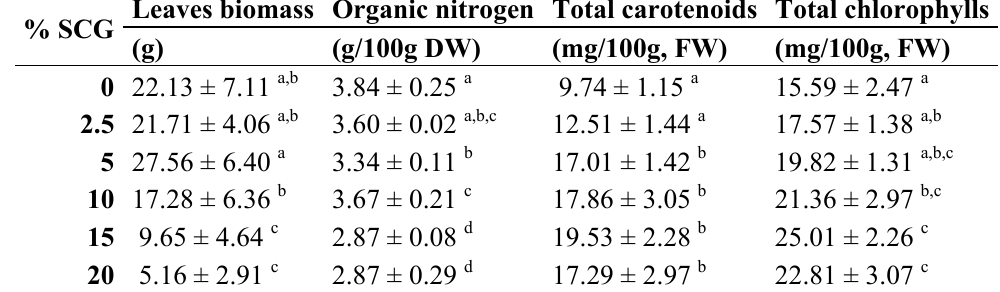
DW: dry weight; FW: fresh weight. a–d indicate the SCG treatments that have statistically significant differences ( p < 0.05) from the given